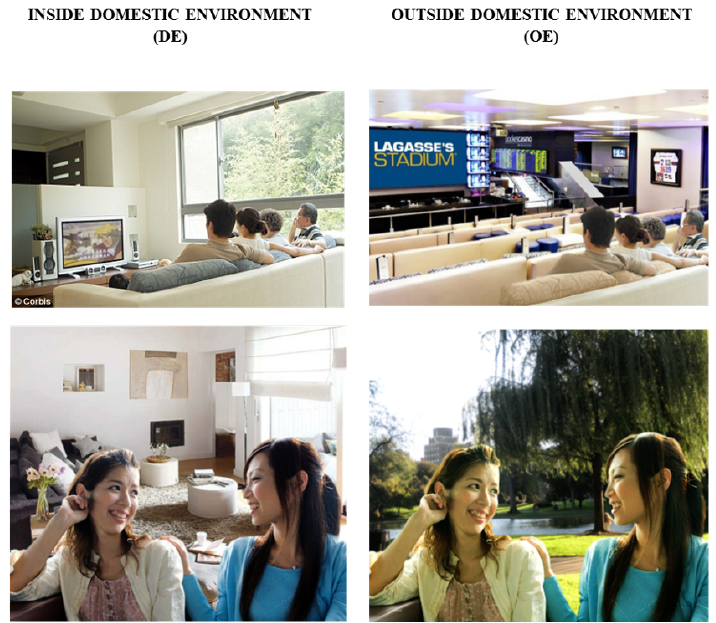
Figure 1. Visual stimuli. Two examples of visual scenes used in the study (actions: above—watching television; below—conversation) in domestic environment (DE) and outdoors environment (OE) conditions. The same person(s) were included in both DE and OE